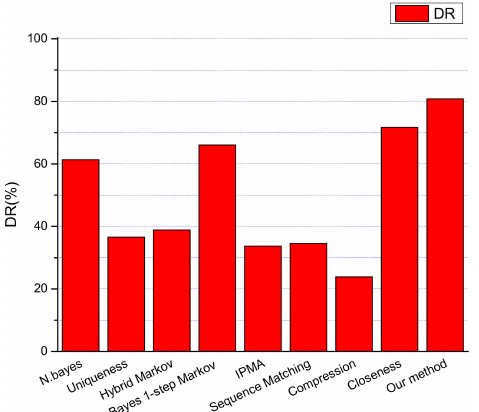
Figure 12. The DR comparation of di ff erent algorithms on